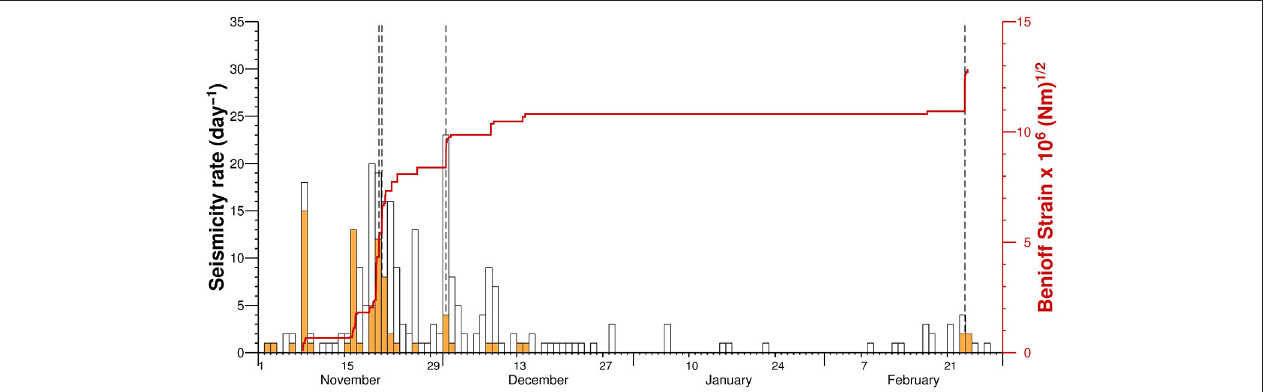
FIGURE 7 | Daily rate and Benioff strain of the earthquakes during the swarm activity in November 2015–February 2016. Orange bars are the daily rate of events relocated using the regional seismic network, and white bars are the same but through single-station location (see Figure 3 ); vertical dashed lines mark the largest events that occurred during the swarm. Red solid line is the cumulative Benioff strain [ P B(t)] defined as the square root of the radiated seismic energy E s expressed in Nmand calculated as log 10 (E s ) = 1.5M + 4.8 ( Grandin et al.,